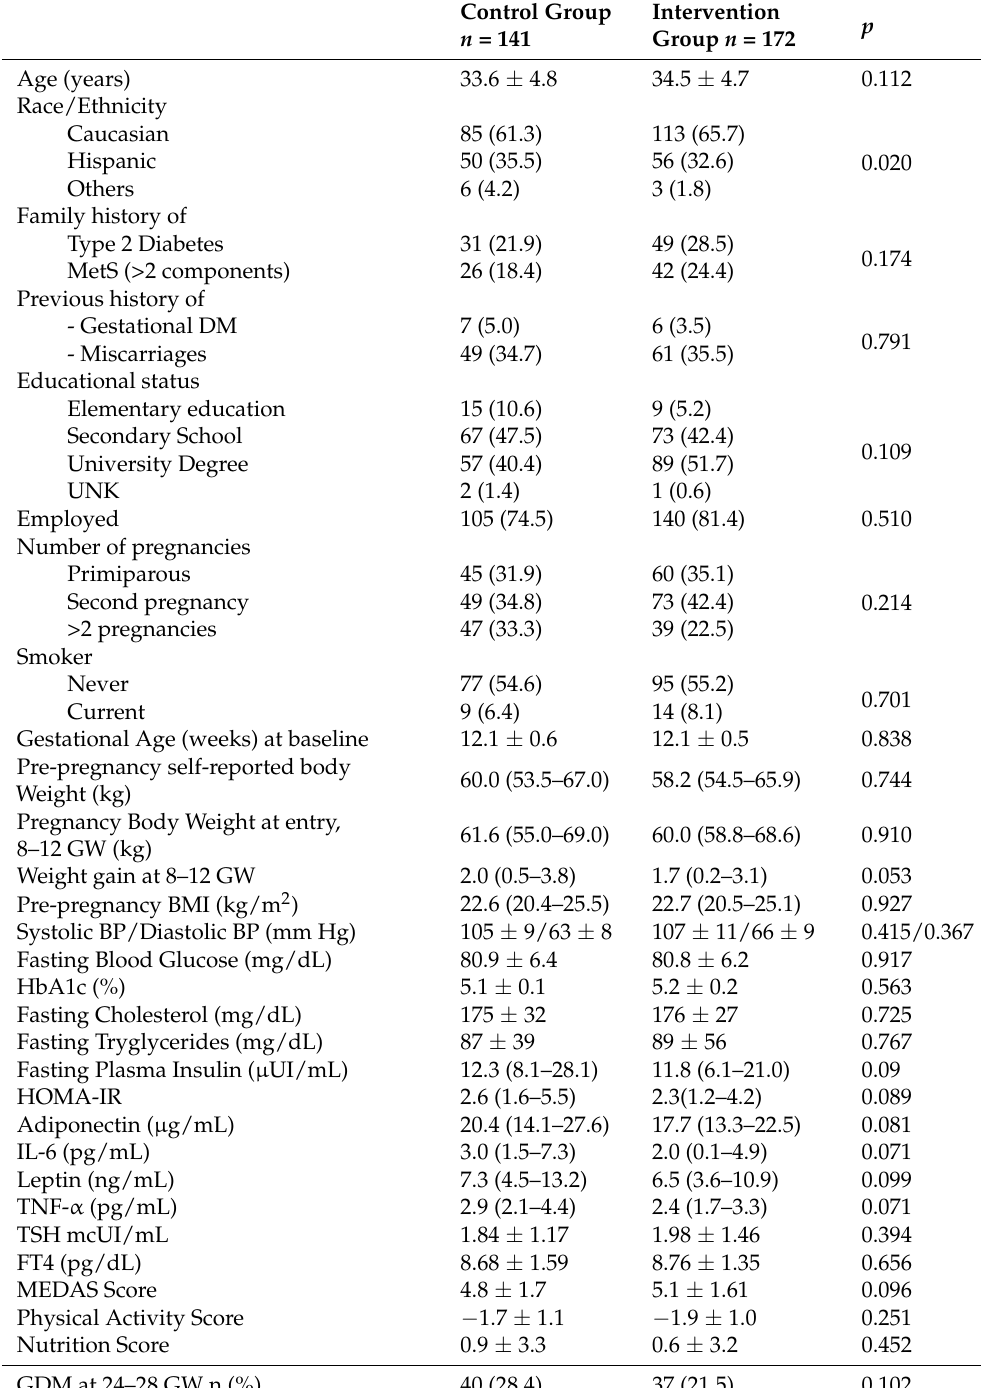
Table 1. Baseline characteristics at 8–12 GW of women